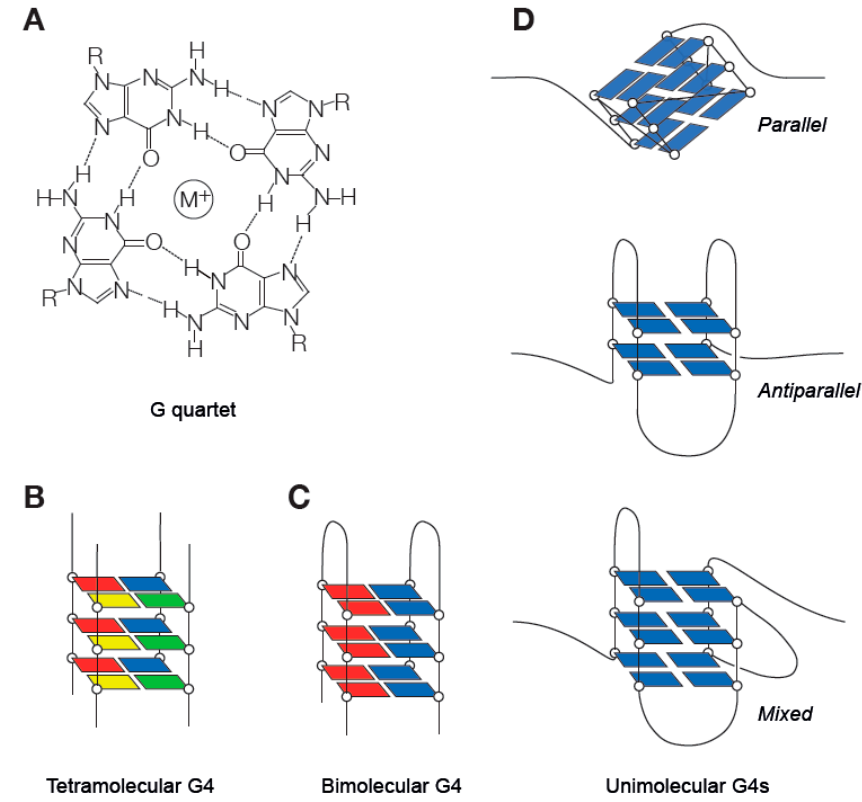
Figure 1. G quartets and G quadruplexes. ( A ) A G quartet. Four G bases form a planar tetrad stabilised by Hoogsteen bonding and a central monovalent metal ion. ( B – D ) Basic forms of the G quadruplex. ( B ) A tetramolecular G4. ( C ) A bimolecular G4. ( D ) Three conformations of unimolecular G4 with different backbone arrangements, parallel, anti-parallel and mixed.